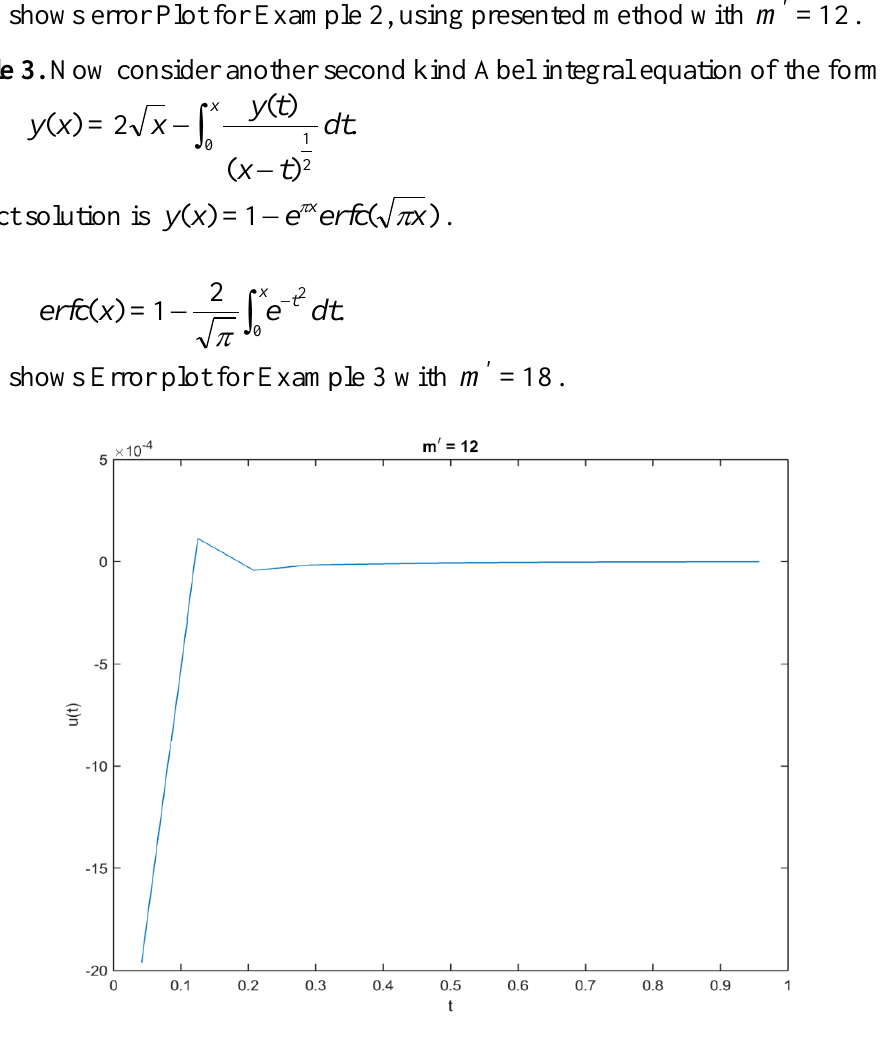
Figure 1. Error plot for Example 1